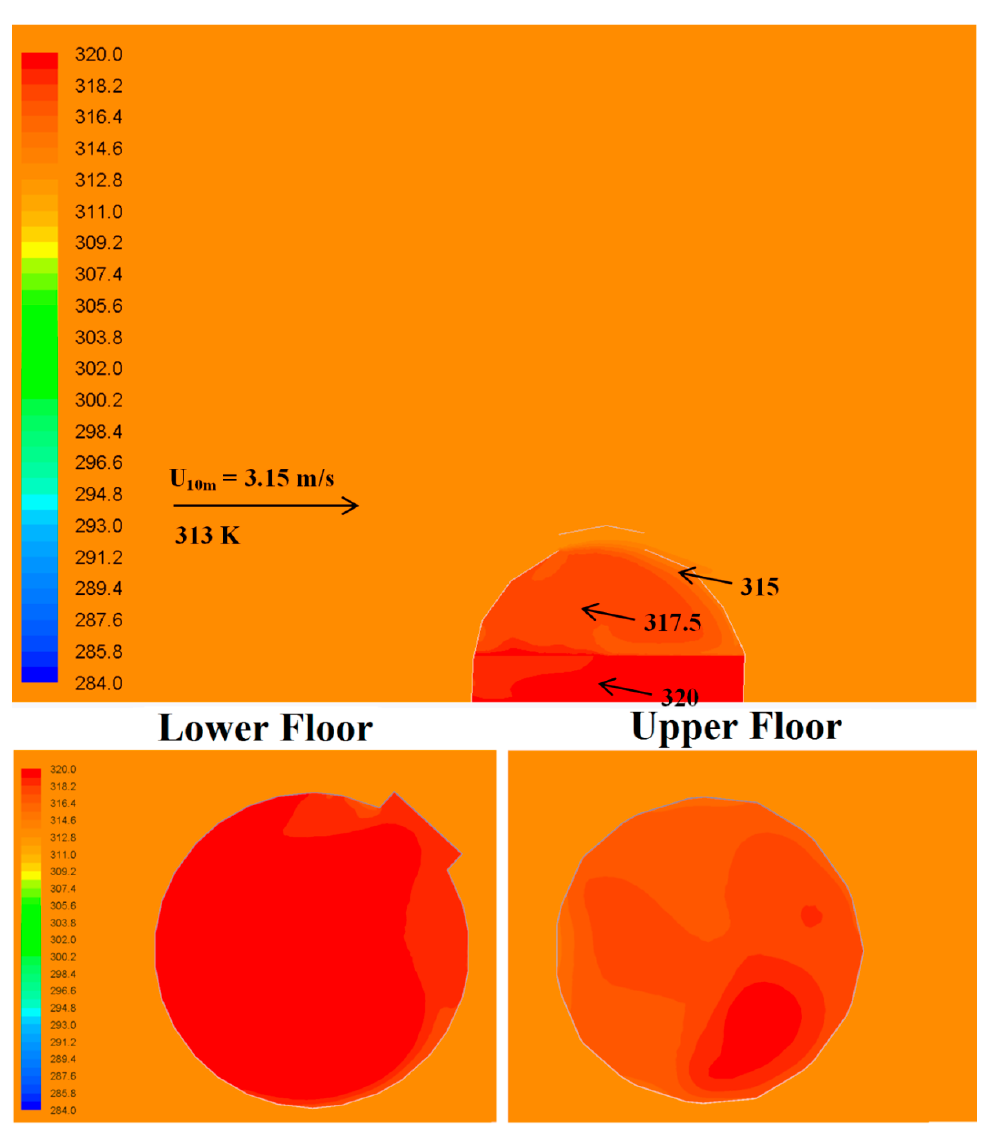
Figure 12. Mid-plane contour plot of the temperature distribution inside the dome during summer month of July (wind-induced flows).